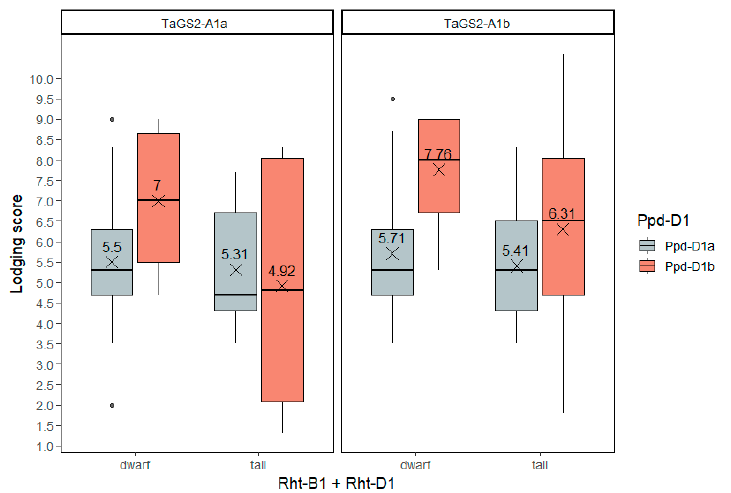
Figure 10. Lodging score BLUEs (9—no lodging, 2—total lodging) for winter wheat genotypes. The dots indicate outliers.